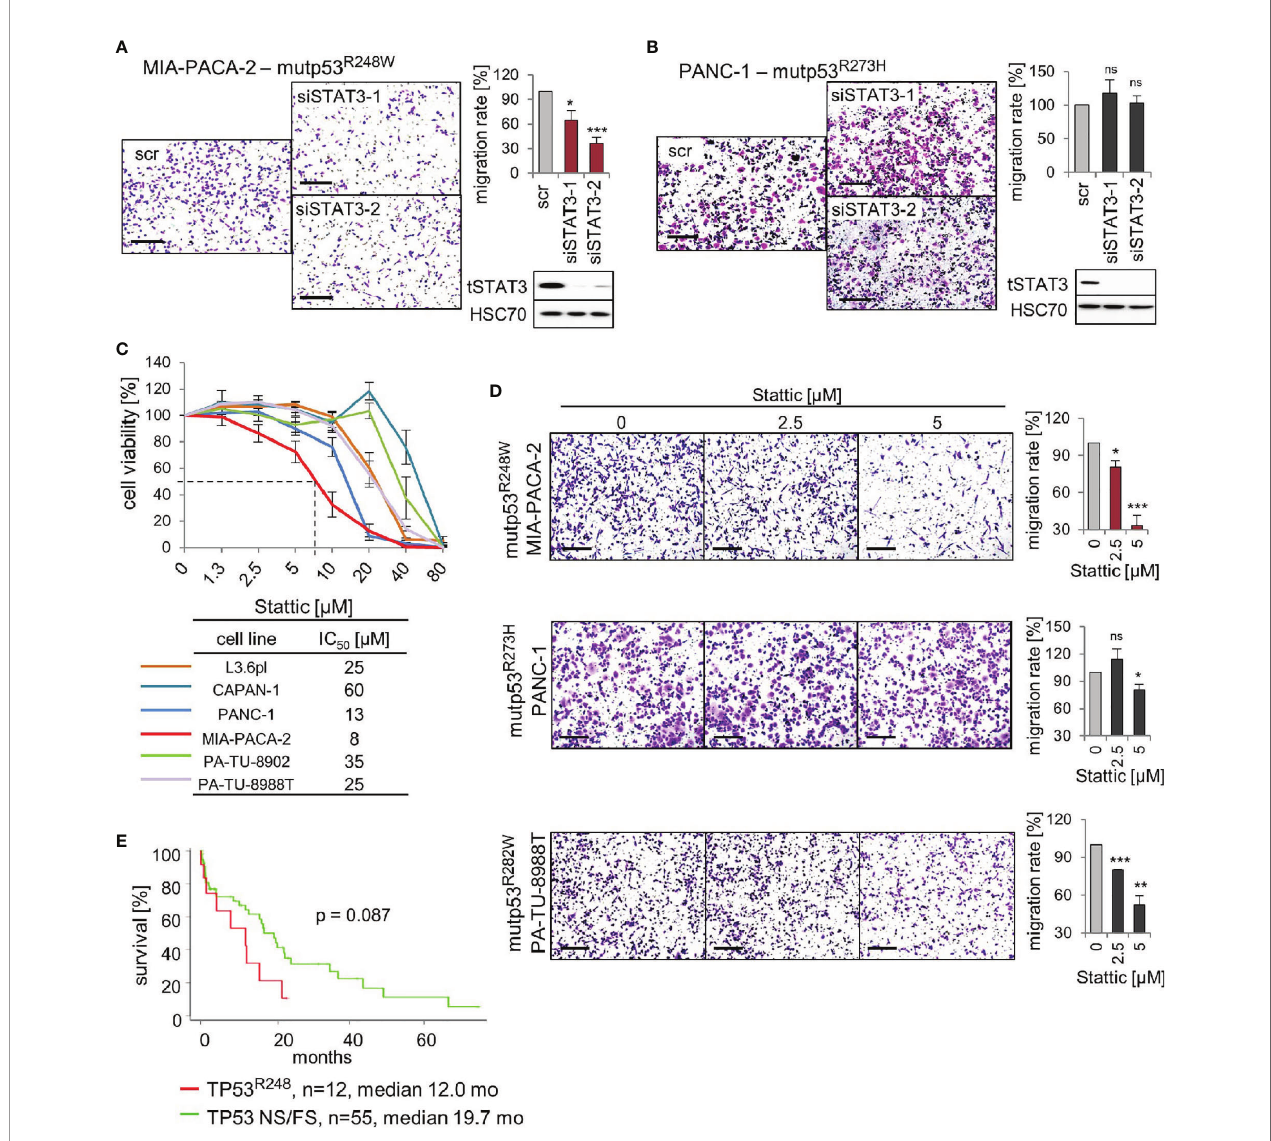
FIGURE 5 | p53 R248W mutant selectively regulates STAT3 phosphorylation and activity in PDAC cells. (A, B) STAT3 knockdown phenocopies mutp53 knockdown in migration assays. MIA-PACA-2 (A) and PANC-1 (B) cells were transfected with two different siRNAs against STAT3 mRNA (siSTAT3-1, -2) or scrambled control (scr). Seventy-two-hour post-transfection cells were seeded into transwell inserts to assess their migration. After 24 h, cells were fi xed, stained, and counted at the membrane underside. Scale bars, 200 µm. MIA-PACA-2 cells: 4 biological replicates (n = 4), PANC-1 cells: 3 biological replicates, 2 out of 3 with 2 technical replicates (n = 5). Cells were calculated relative to scrambled control. Immunoblot analysis to con fi rm knockdown of STAT3. HSC70, loading control. (C) Cell viability assays of the indicated PDAC cell lines. Dose response curve after treatment with increasing concentrations of the STAT3 inhibitor Stattic or solvent control for 24 h. For each cell line, three to four biological replicates were measured. Diagram represents means ± SEM. From these curves, IC 50 values were determined, indicated in the table. Of note, MIA-PACA-2 cells are the most sensitive to Stattic treatment, indicated by the dashed line. (D) STAT3 inhibition phenocopies mutp53 knockdown in migration assays. Transwell migration assays of MIA-PACA-2, PANC-1, and PA-TU-8988T cells treated with the indicated concentrations of Stattic for 24 h. Scale bars, 200 µm. For all cell lines, quanti fi cation of two biological replicates, one of them with two technical replicates (n = 3 total), calculated relative to 0 µM control treatment. (E) Survival curve of PDAC patients harboring TP53 R248 mutations versus patients harboring TP53 nonsense or frameshift (NS/FS) mutations. Number of patients and mean overall survival in months as indicated. TCGA data. Kaplan – Meier statistic, log-rank test. (A, B, D) Diagrams represent the means ± SEM. Student ’ s t test. *p ≤ 0.05; **p ≤ 0.01; ***p ≤ 0.001; ns, not signi fi